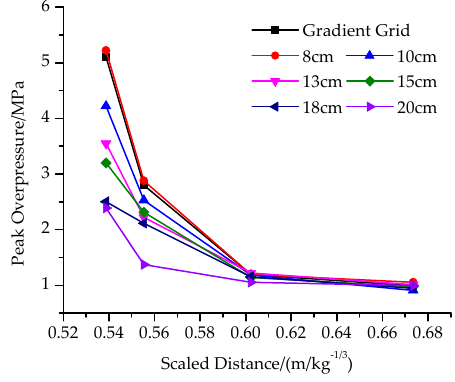
Figure 4. Peak overpressure versus scaled distance under different step size.